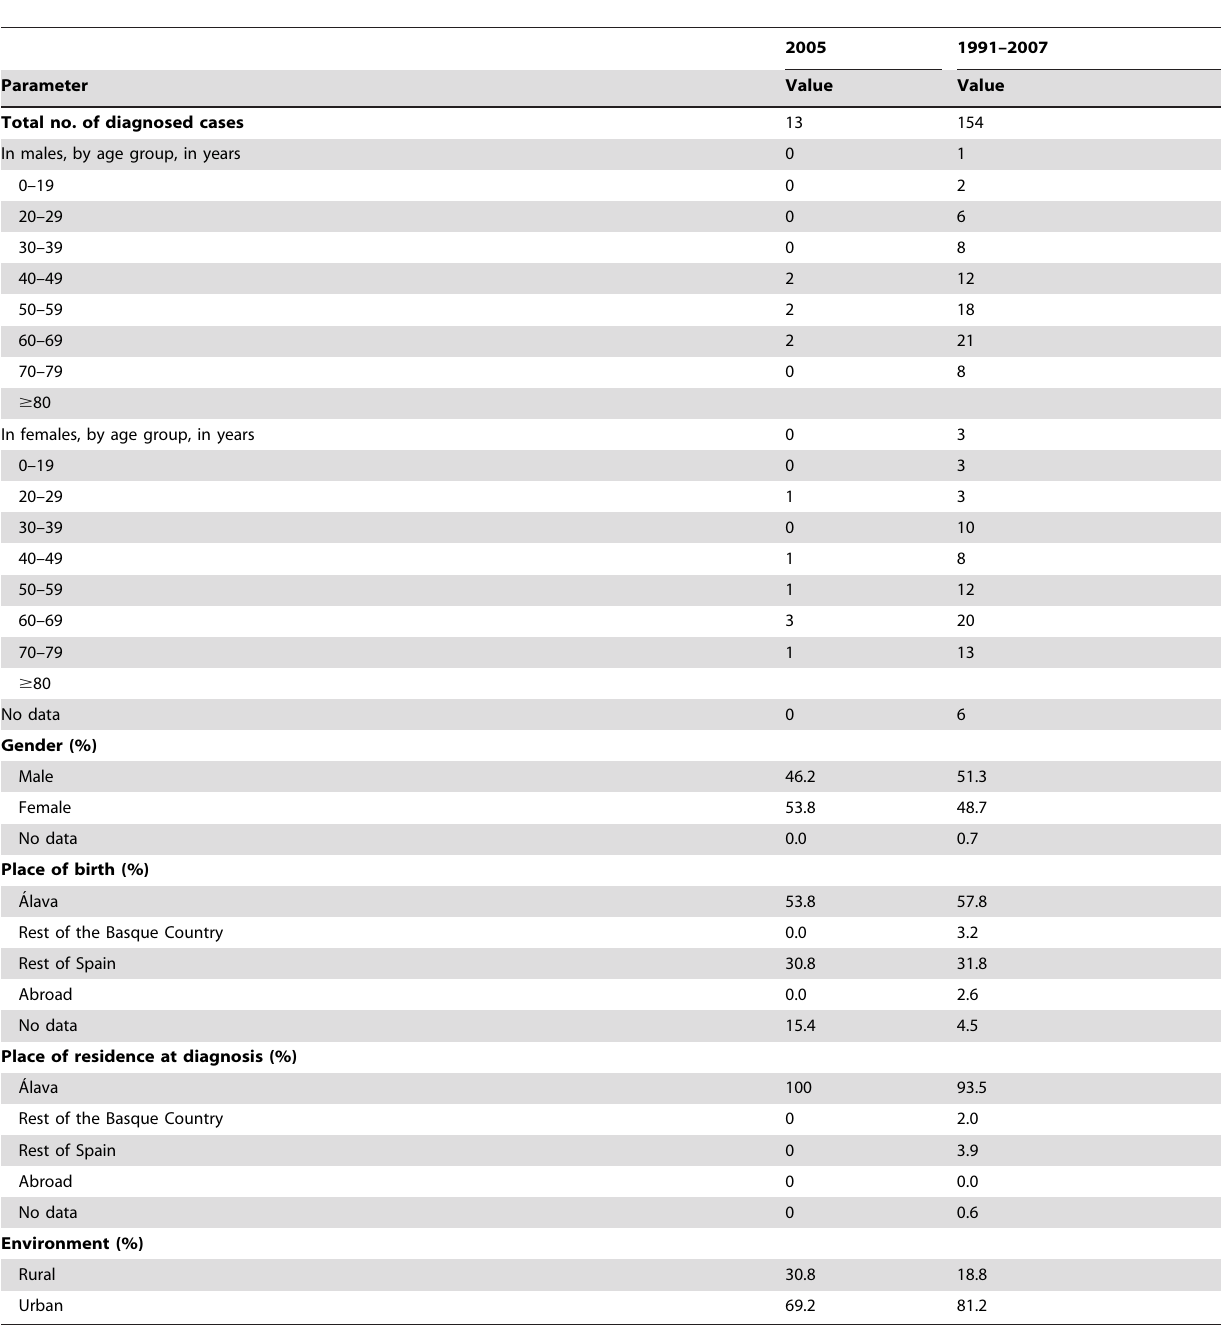
Table 7. Human CE epidemiological parameters based on individual hospital clinical histories in A´lava,